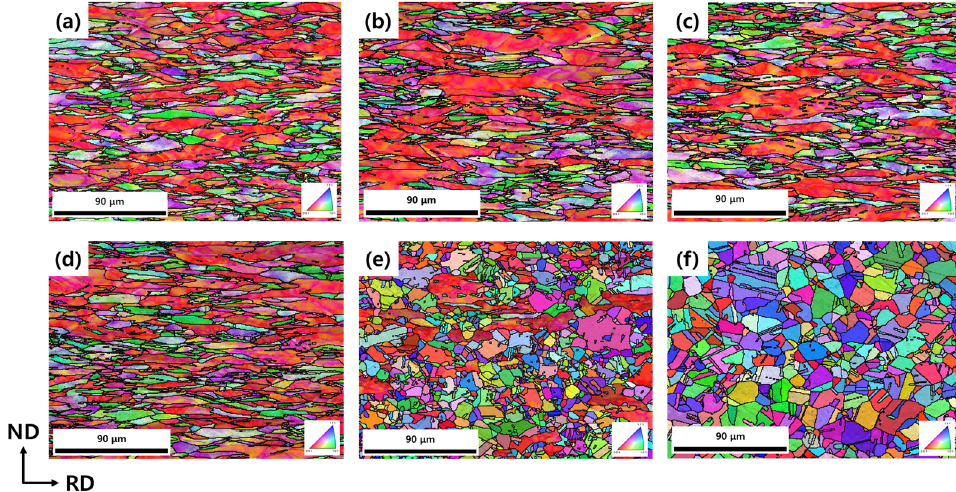
Figure 1. Normal direction inverse pole figure (IPF) map of the ( a ) cold-rolled, ( b ) 400 °C, ( c ) 500 °C, ◦ C, ( e ) 800 ◦ C, and ( f ) 900 ◦ C heat treated ( d ) 700 °C, ( e ) 800 °C, and ( f ) 900 °C heat treated specimens. ( d ) 700